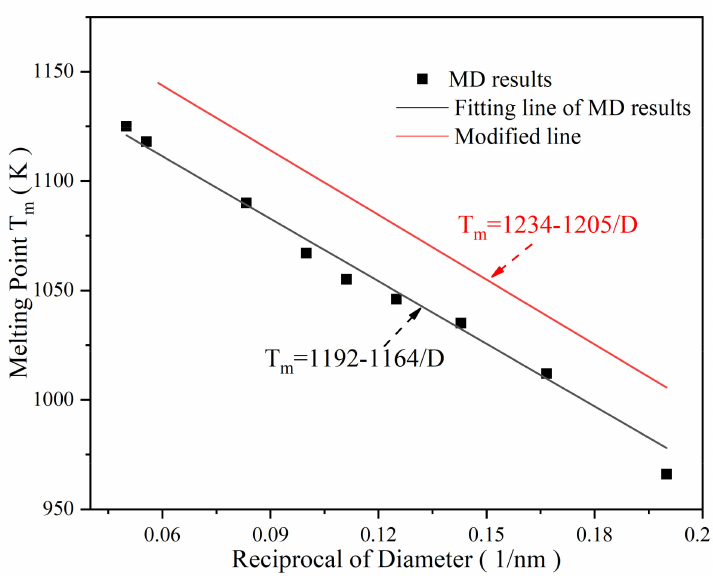
Figure 3. Melting point of nanoparticles as a function of the reciprocal of diameter.